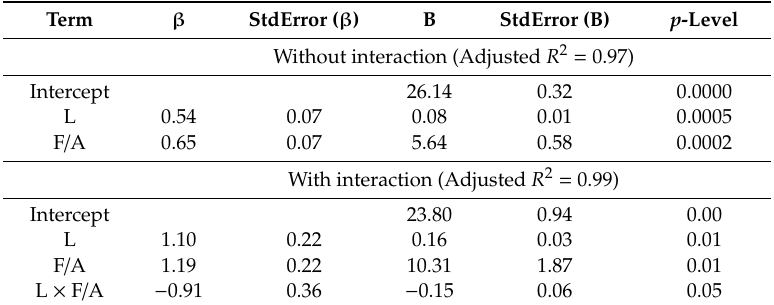
Table 4. Results of multiple regression model. In this run, the IWQ was used as a dependent variable.